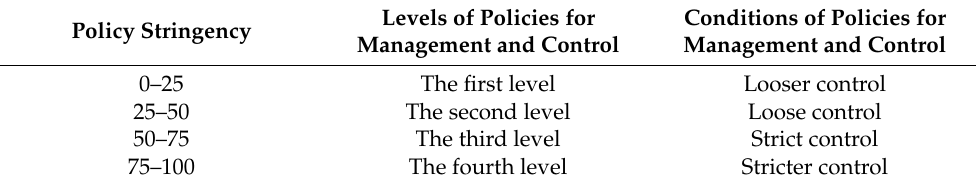
Table 3. Classification of policy